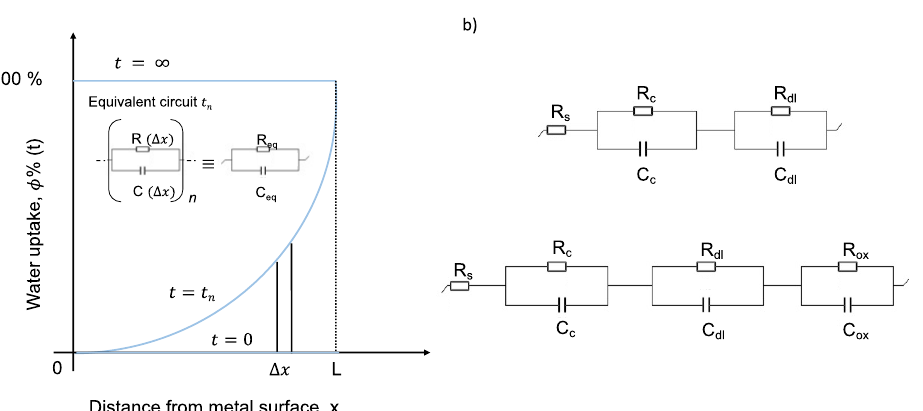
Figure 3. ( a ) Schematic representation of a water uptake profile in a coated system of thickness L and equivalent electric circuit following the continuous model (CM); ( b ) equivalent circuits (with two and three characteristic time constants) used to model EIS and ACET data of the analyzed coated samples.